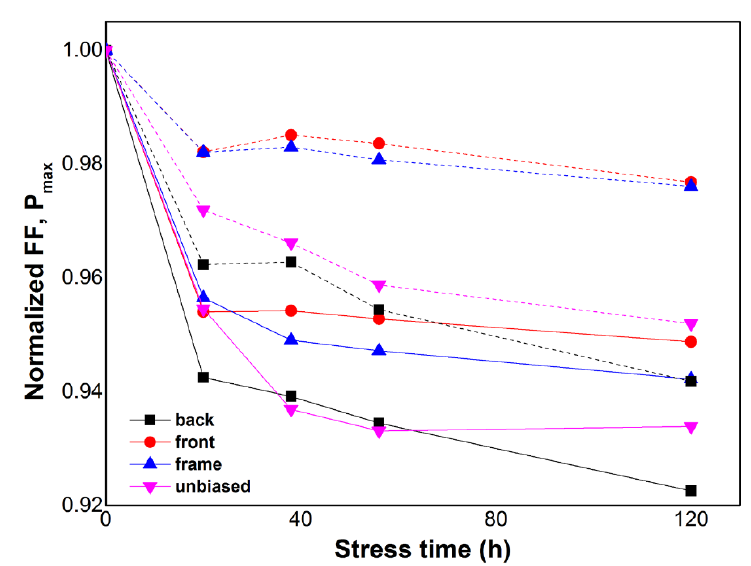
Figure 7. Normalized maximum power (solid lines) and fill factor (dashed lines) of the tested modules as a function of time with positive voltage.